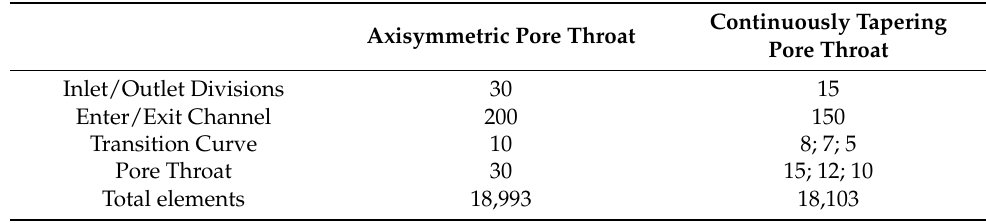
Table 2. Meshing Grids in Each